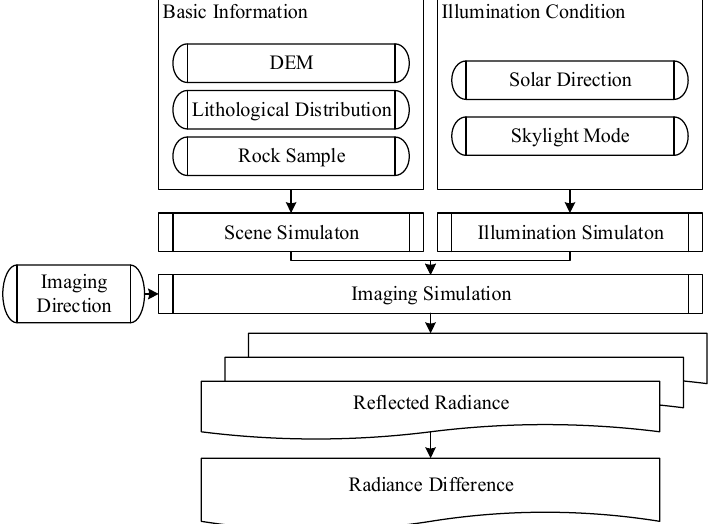
Figure 10. Flowchart of physical simulation experiment.